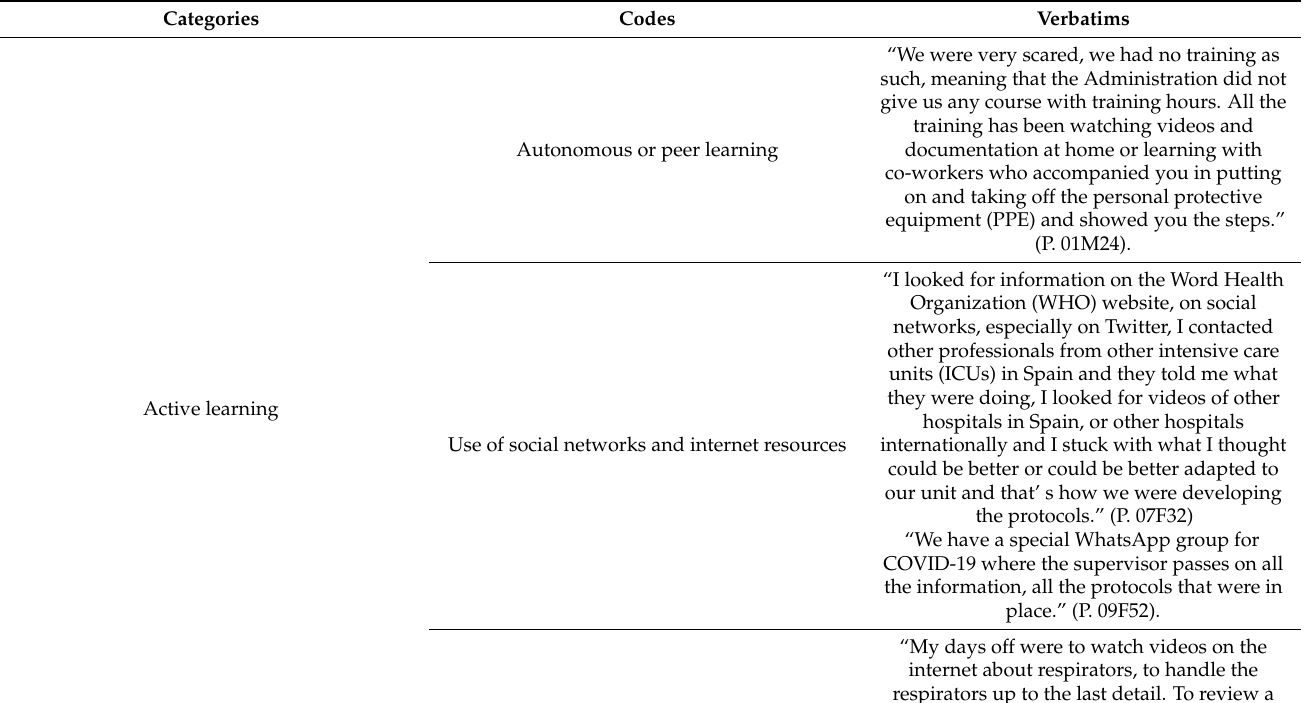
Table 4. Categories, codes, and verbalizations for Theme 2: Coping strategies for ethical conflicts experienced during the